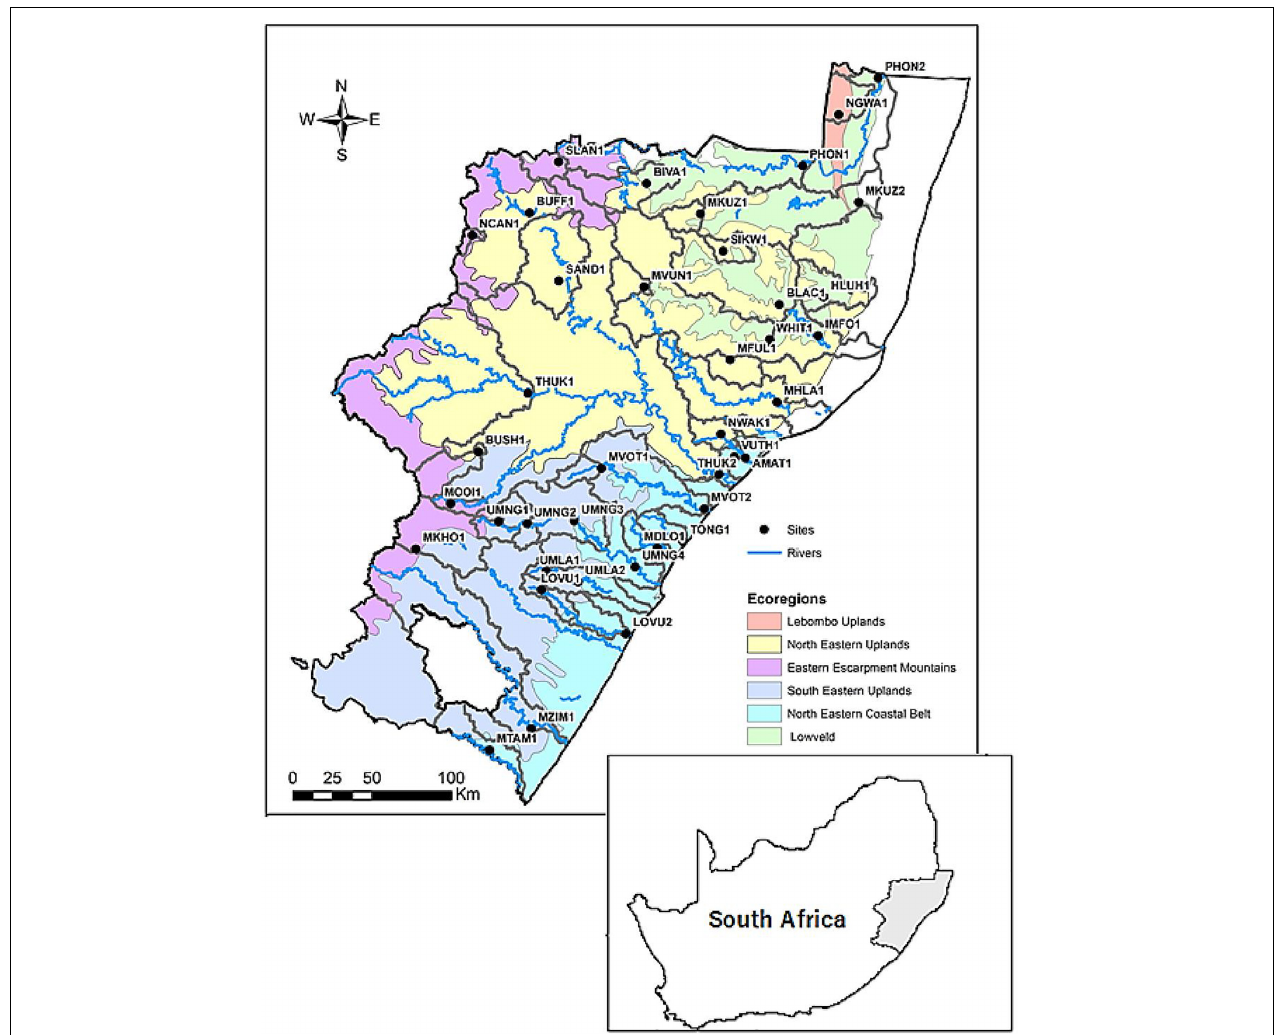
FIGURE 1 | River study sites in KwaZulu-Natal, South Africa for the study from March 2015 to March